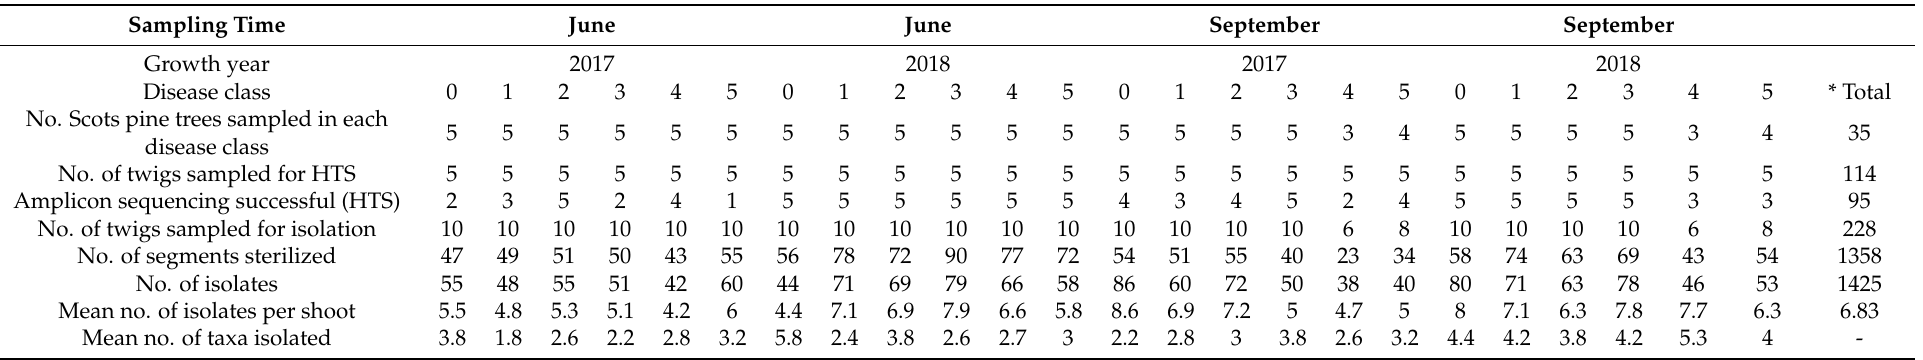
Table 1. Year and timing of sample collection for culture-based identification of endophytes and HTS-based identification of the microbiome of Scots pine twigs collected from a total of 35 trees, covering all the disease classes. * Total = the sum of each